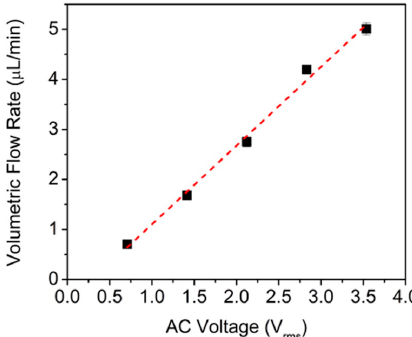
Figure 12. Volumetric flow rate as a function of the applied sinusoidal voltage. Reproduced with permission from [33]. American Chemical Society, 2016.